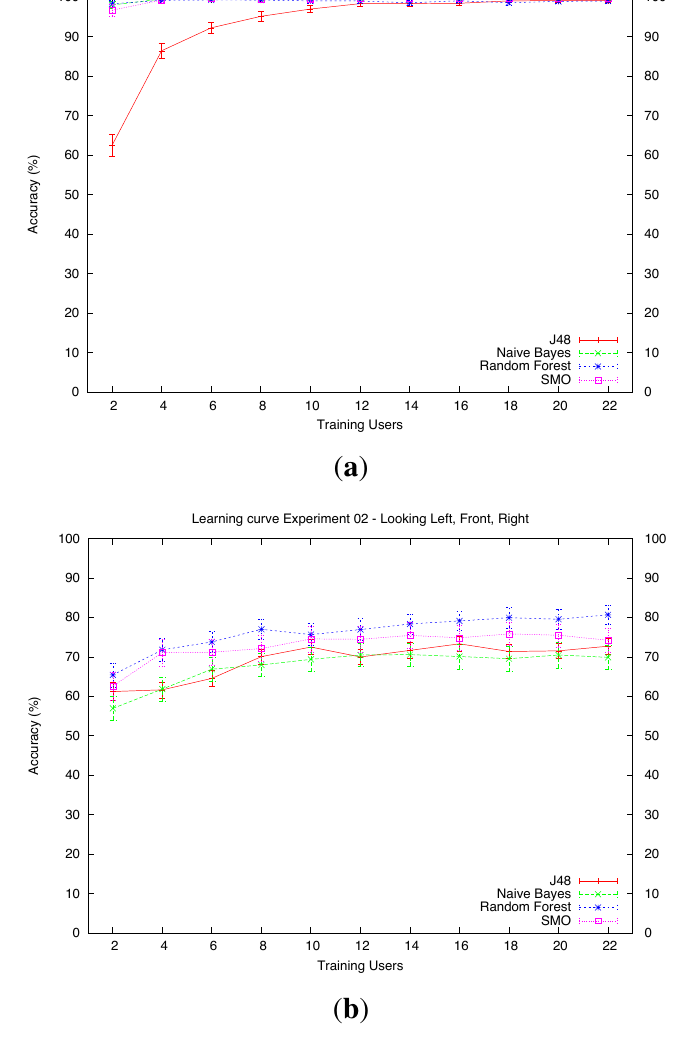
Figure 6. Learning curves for the three datasets. ( a ) Dataset D ( b ) dataset D (looking left, front, right); ( c ) dataset D 2